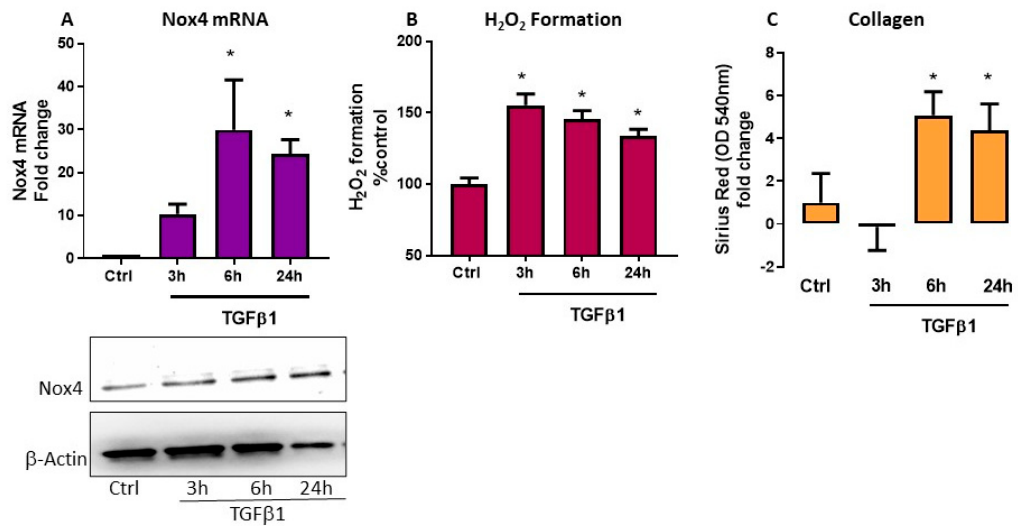
Figure 1. E ff ect of transforming growth factor (TGF) β 1 in human Tenon’s fibroblasts (HTFs). Responses were determined in control fibroblasts without and with TGF β 1 (5 ng / mL) treatment for 3, 6, and 24 h. TGF β 1 caused increase in ( A ) Nox4 mRNA and protein expression and ( B ) H 2 O 2 generation. ( A ) A representative blot and corresponding bar graph showing expression of Nox4 and internal control β -actin. ( C ) Collagen accumulation was determined by the absorbance values of Picrosirius red determined at 540 nm and TGF β 1 increases absorbances at 6 and 24 h. * p < 0.05 ( n = 3–5). All data are mean ± SEM from three to five independent experiments, * p < 0.05 from Ctrl. without treatment.